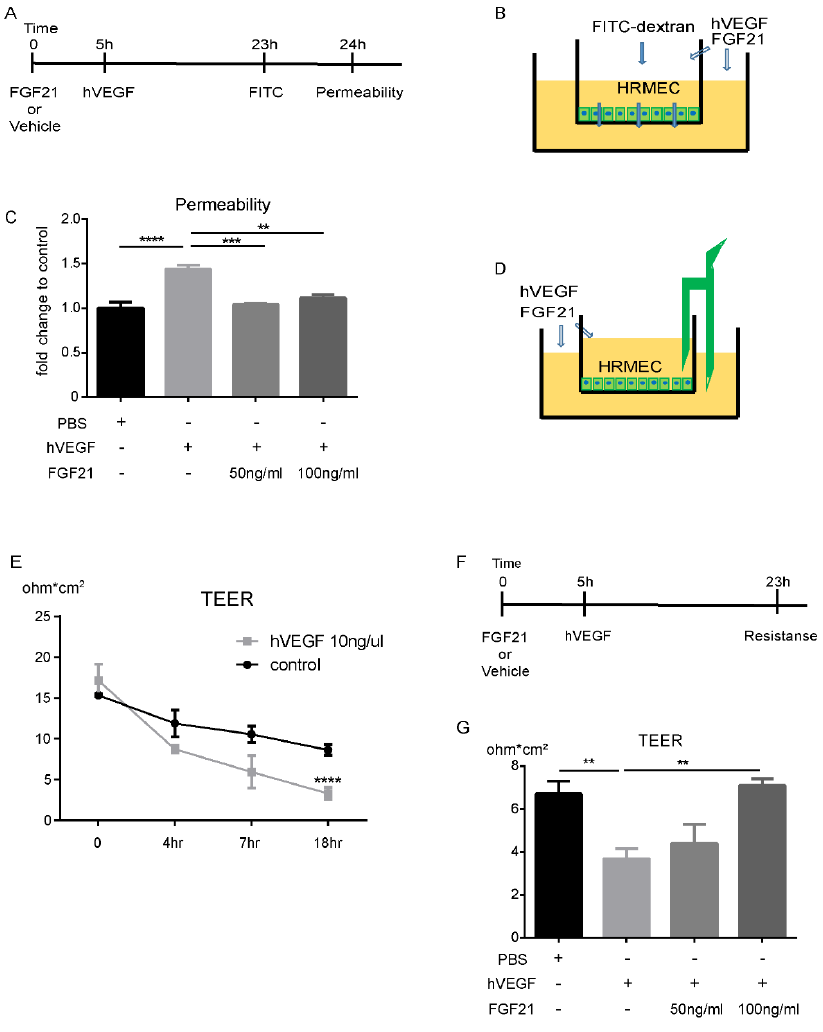
Figure 3. FGF21 decreases vascular leakage in primary human retinal microvascular